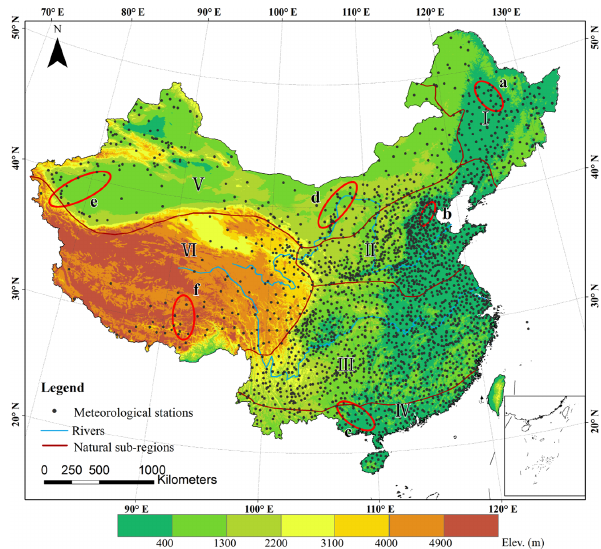
Figure 1. The study area is divided into six natural subregions (I, II, III, IV, V and VI), and the spatial distribution of the meteorolog- ical stations in the subregions is shown. The red ellipses mark key areas where the temperature has changed significantly, and meteo- rological stations from subset (2) located in these areas referring to Sect. 3.2 are used to validate the accuracy of the new LST dataset (a, b, c, d, e and